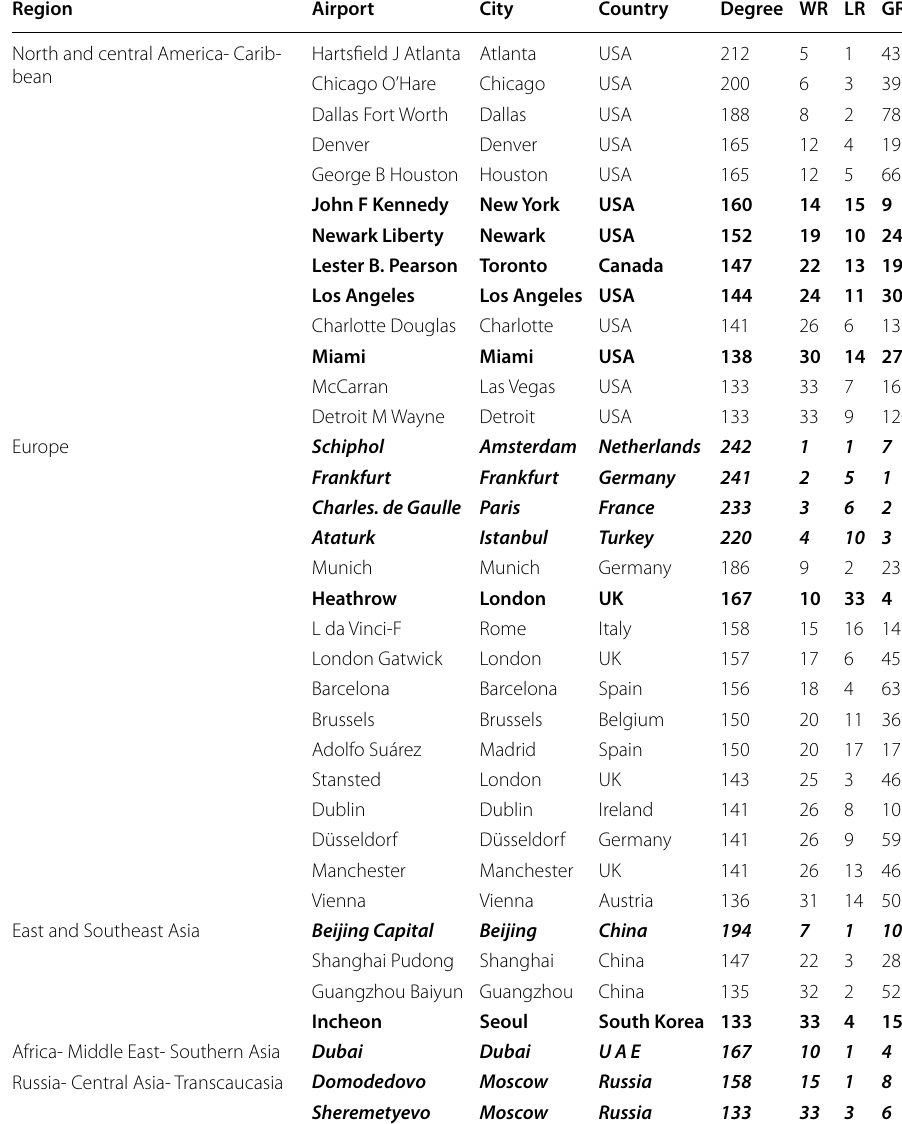
WR is the worldwide rank in the world air transportation network. It is computed using the total degree (internal and external). LR is the local rank computed in the large local components. GR is the global rank in the global component. No indication is given when an airport does not belong to the global component. Top inter-regional airports are in bold. Top regional and inter-regional airports are in bold and italic. Others are top regional airports